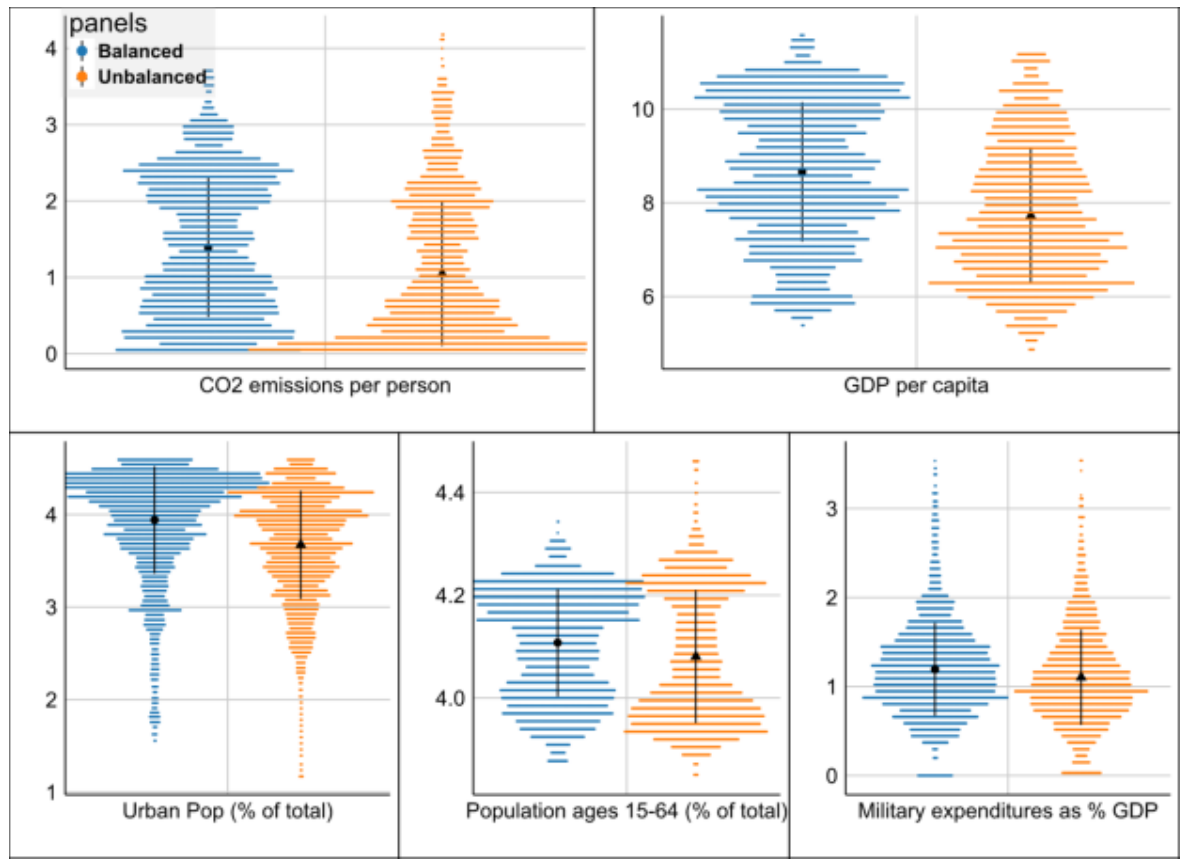
Figure 3 . Comparison of Variable Distributions by Inclusion or Exclusion in Balanced